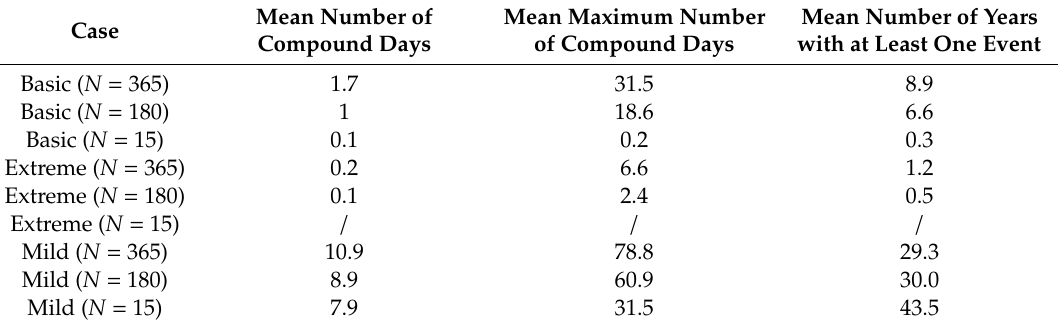
Table 1. Impact of the input parameters used for the definition of compound events related to the basic characteristics of the identified